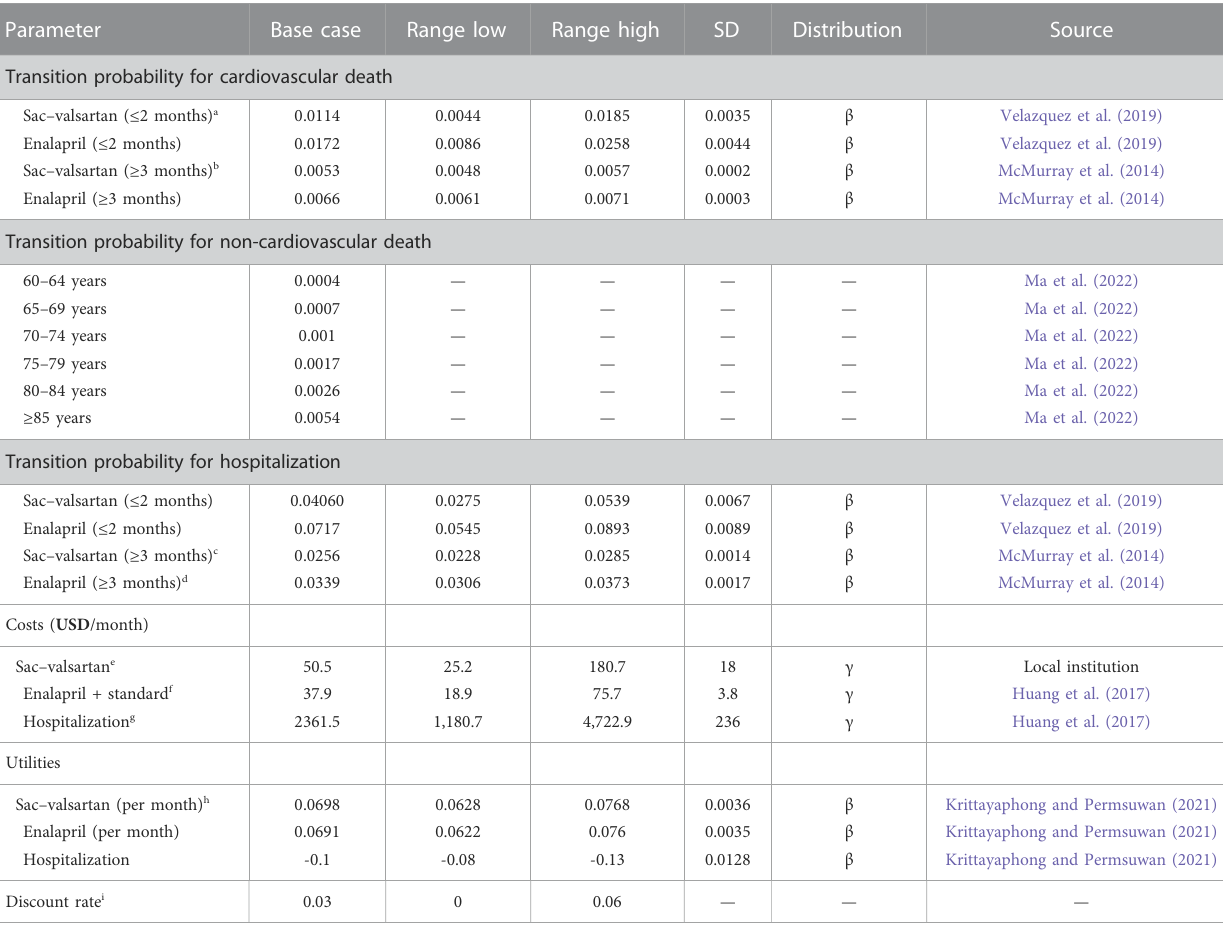
TABLE 2 Input parameters of the Markov